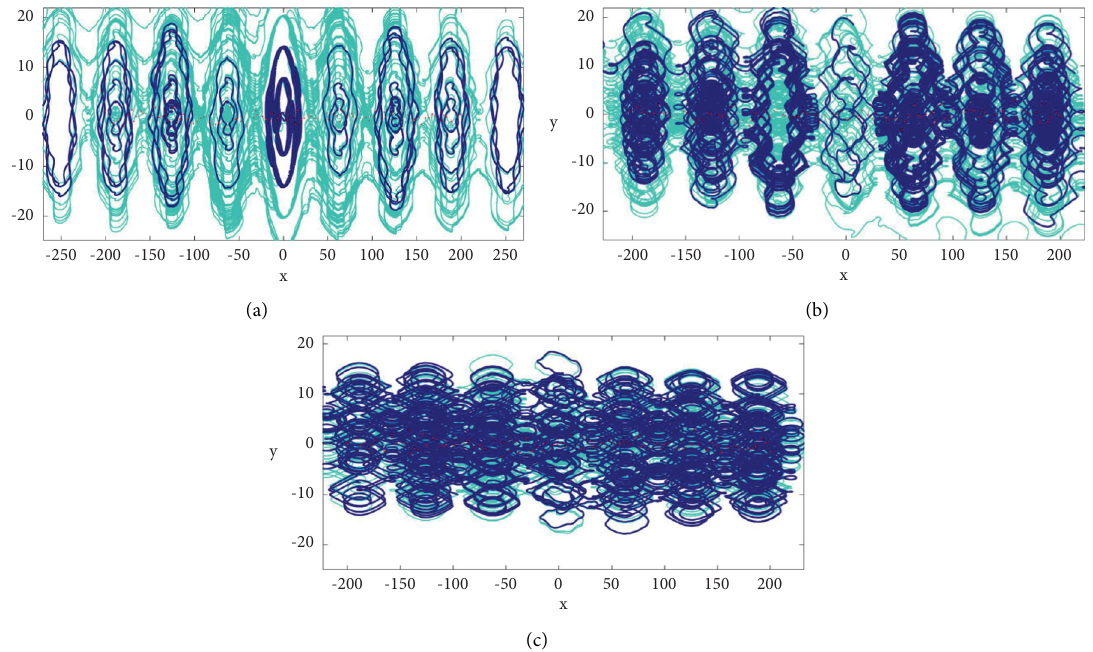
Figure 4: Coexisting attractors in System (2) resulted from random initial conditions distributed around the x -axis. The transients are shown in cyan, and steady states are shown in dark blue. The frequency of the forcing term is ω � 0 . 6, and the amplitude is (a) A � 2, (b) A � 4 . 3, and (c) A � 9 . 7. Increasing the amplitude of the forcing term leads to more overlapped